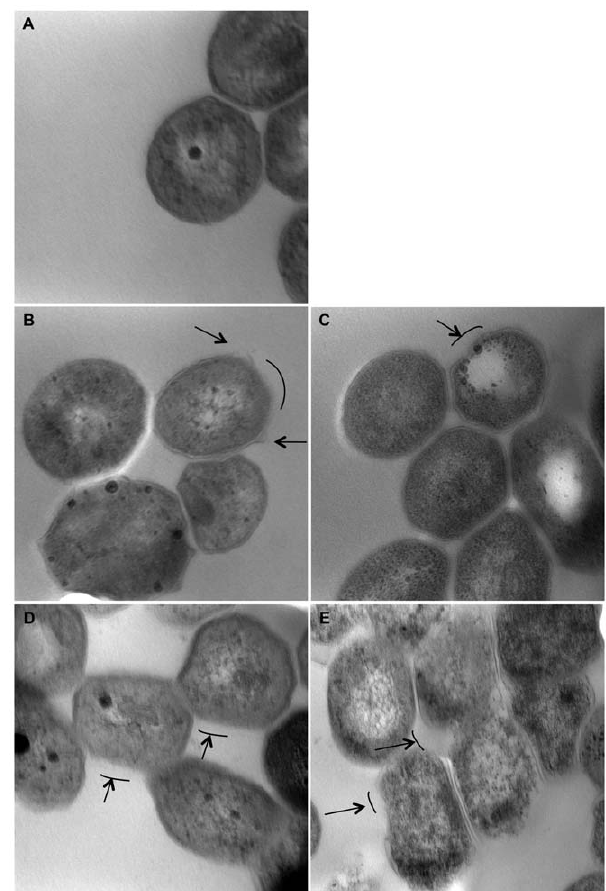
Figure 2. TEM images of unexposed Mtb CDC 1551 control (A) and following incubation for 6 hr (B, C) and 24 hr (D, E) with 1x MIC (B, D)/4x MIC (C, E) THZ respectively. The arrows and lines highlight areas of noticeable cell wall